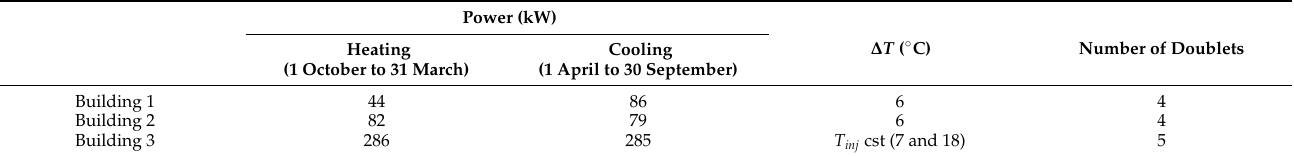
Table 1. Mean power extraction by the different ATES systems in Buildings 1, 2 and 3 and the associated assumed ∆ T